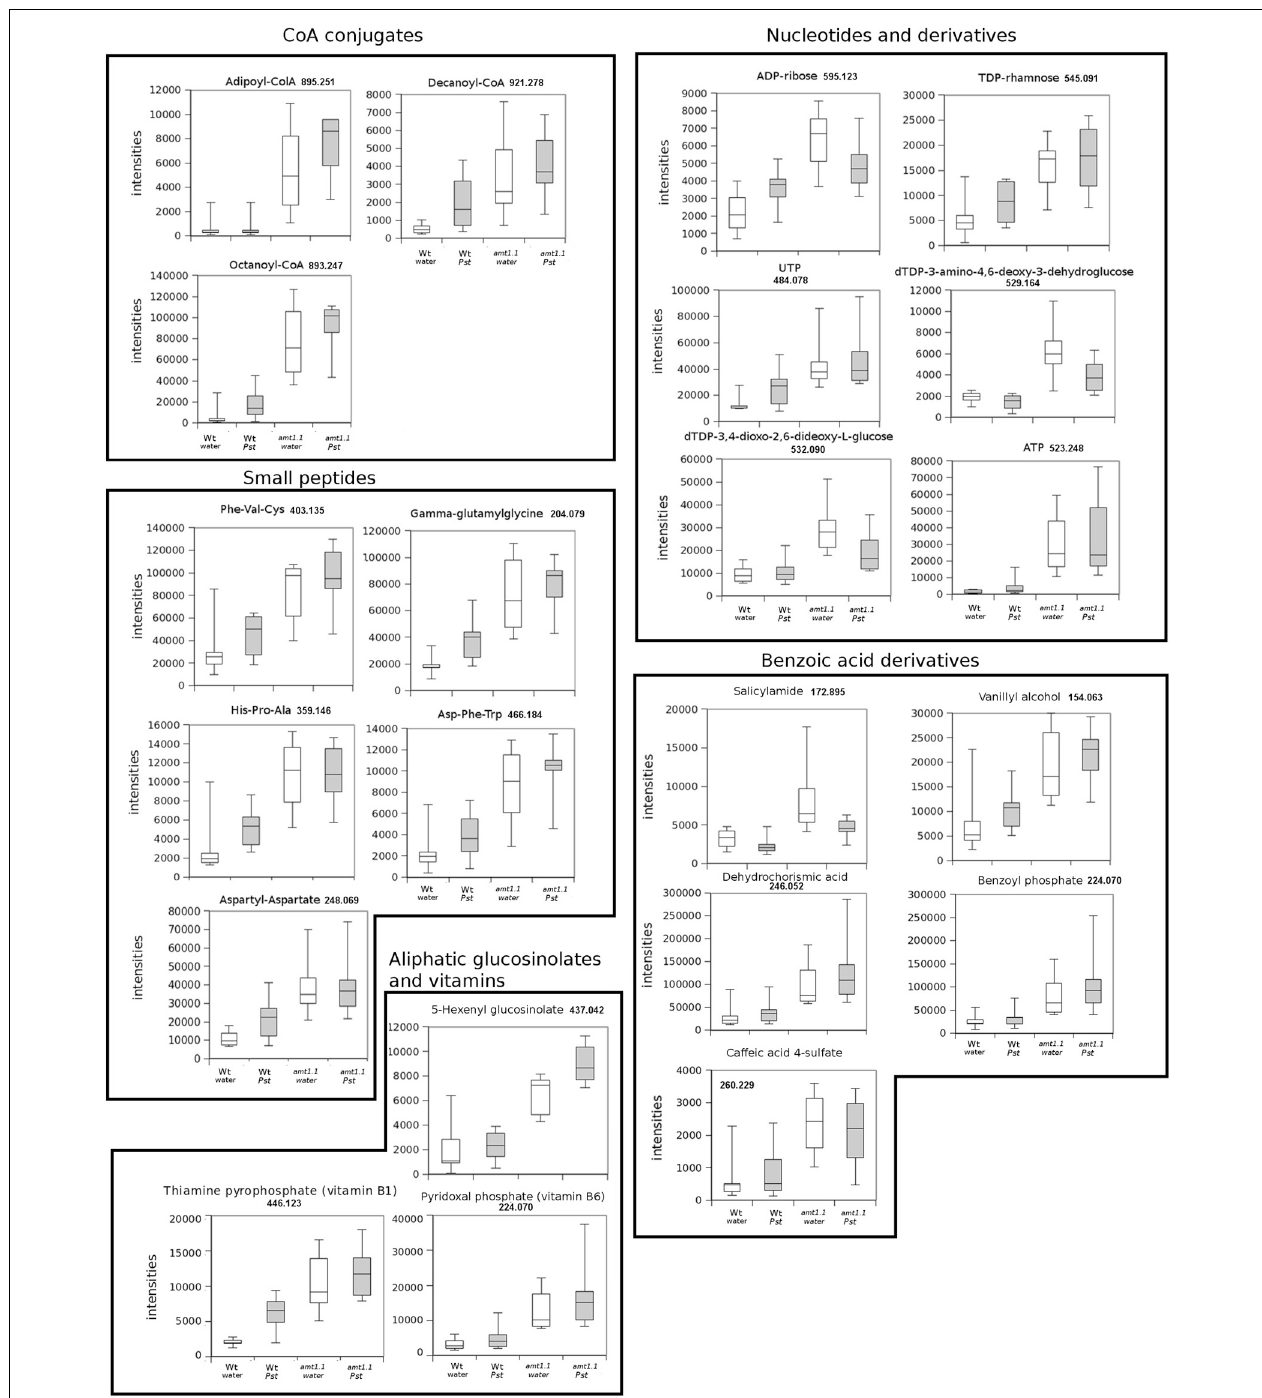
FIGURE 8 | Profiling of the main hits in the overaccumulated compounds upon P. syringae (Pst) infection in amt1.1 compared with Col3-gl1 . Five week old Col3-gl1 and amt1.1 were infected as described in Figure 1 . After 48hpi plants were processed for relative quantification analysis by HPLC-QTOFMS data. The concentration of the metabolites was determined in all the samples by normalizing the chromatographic area for each compound with the dry weight of the corresponding sample. The compounds were tentatively identified using the exact mass